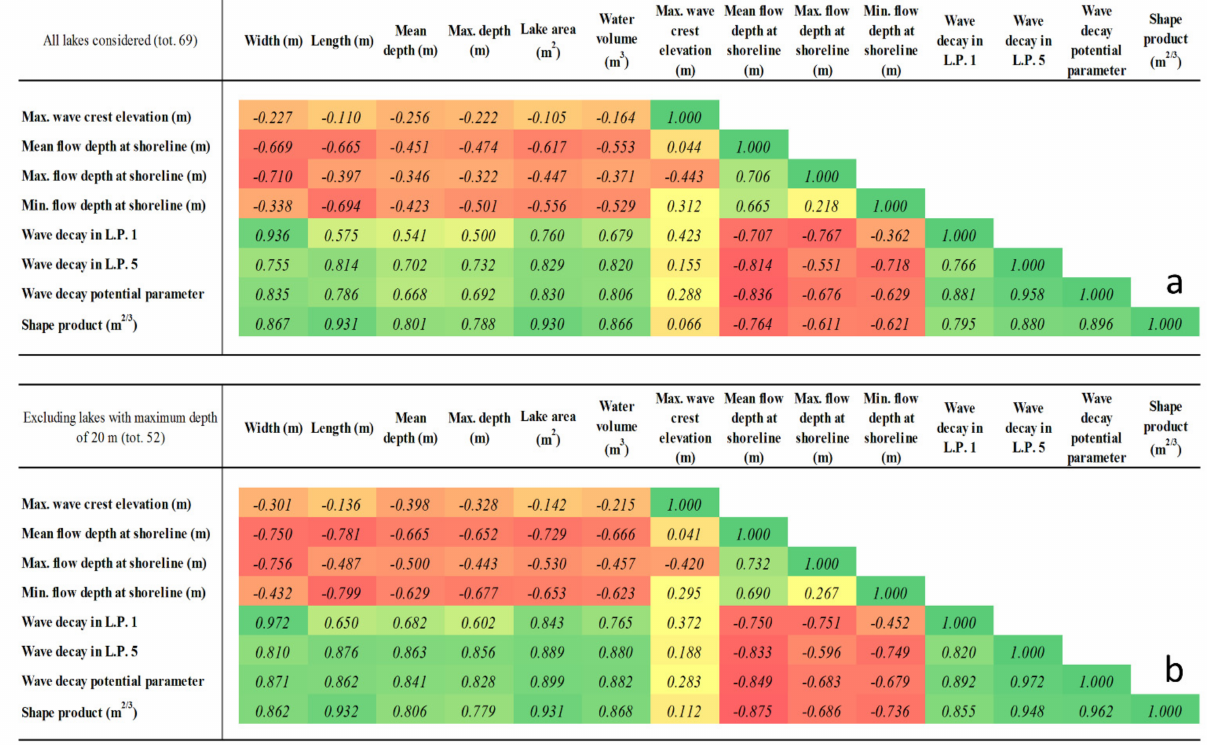
Figure 6. Correlation matrices show the correlation coefficients ( r ) between lake geometrical characteristics and the hydrodynamic modeling results. ( a ) Matrix for all lakes (69 models). ( b ) Matrix for all lakes with a maximum depth greater than 20 m (52